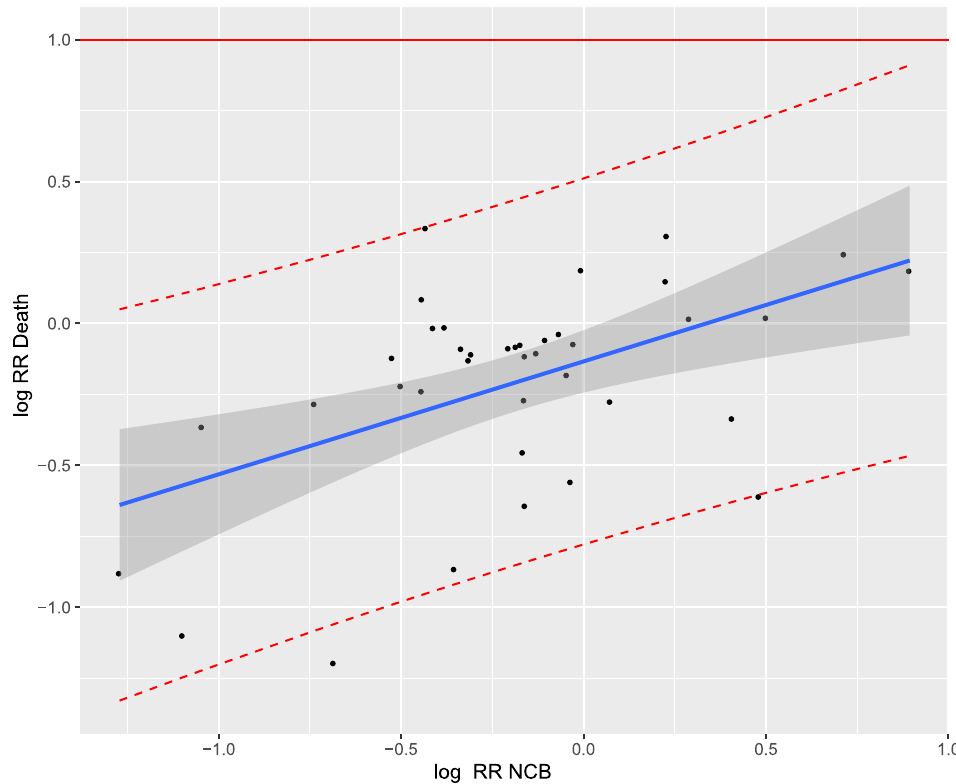
Figure 3. Trial-level association between treatment effects on net clinical benefit (NCB) and all-cause mortality in the treatment of non-valvular atrial fibrillation. The correlation was (Cor) = 0.62 with the linear regression model: "Log RR Death = 0.44 × Log RR NCB − 0.11”. Each study is represented by a circle. A log scale was used for the x-axis and y-axis. The solid blue line represents the regression line and the grey area represents the 95% confidence interval. The red dashed lines represent the upper and lower limits of the 95% prediction interval. RR, relative